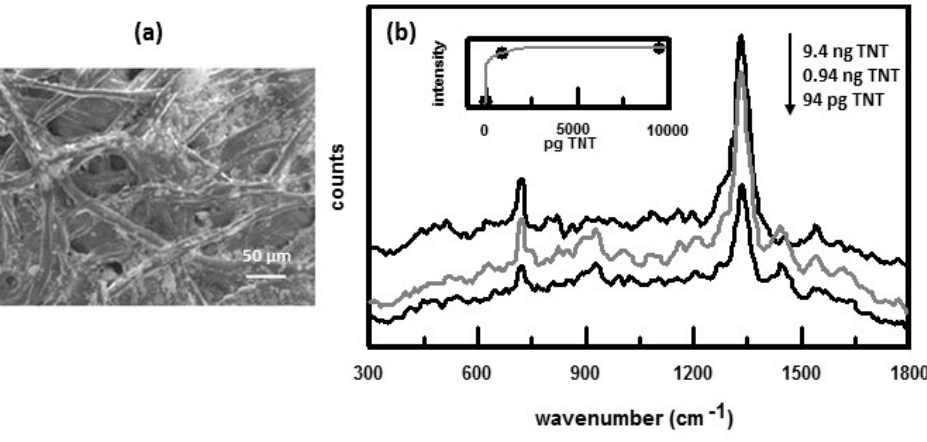
Figure 7. ( a ) SEM of printed Au NPs on filter paper; ( b ) SERS spectra of TNT. Concentrations are indicated. Inset shows the variation of SERS intensity of NO 2 band as a function of concentration. Reproduced with permission from Hindawi Publishing Corporation, 2012 [42].